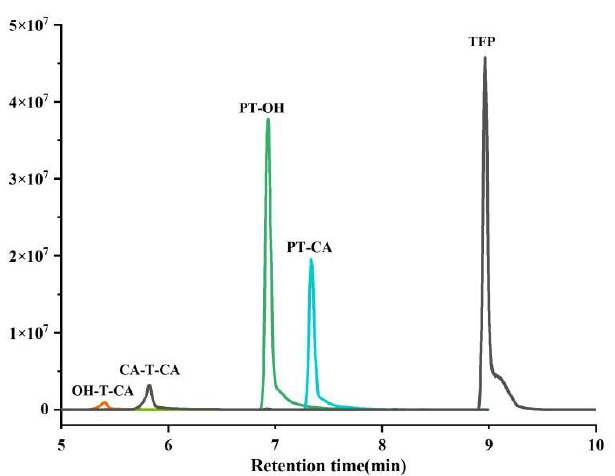
Figure 3. An overlay of MRM chromatograms of TFP and its metabolites in the green tea matrix- matched standard (2.5 mg kg − 1 ) acquired using the optimised MS/MS